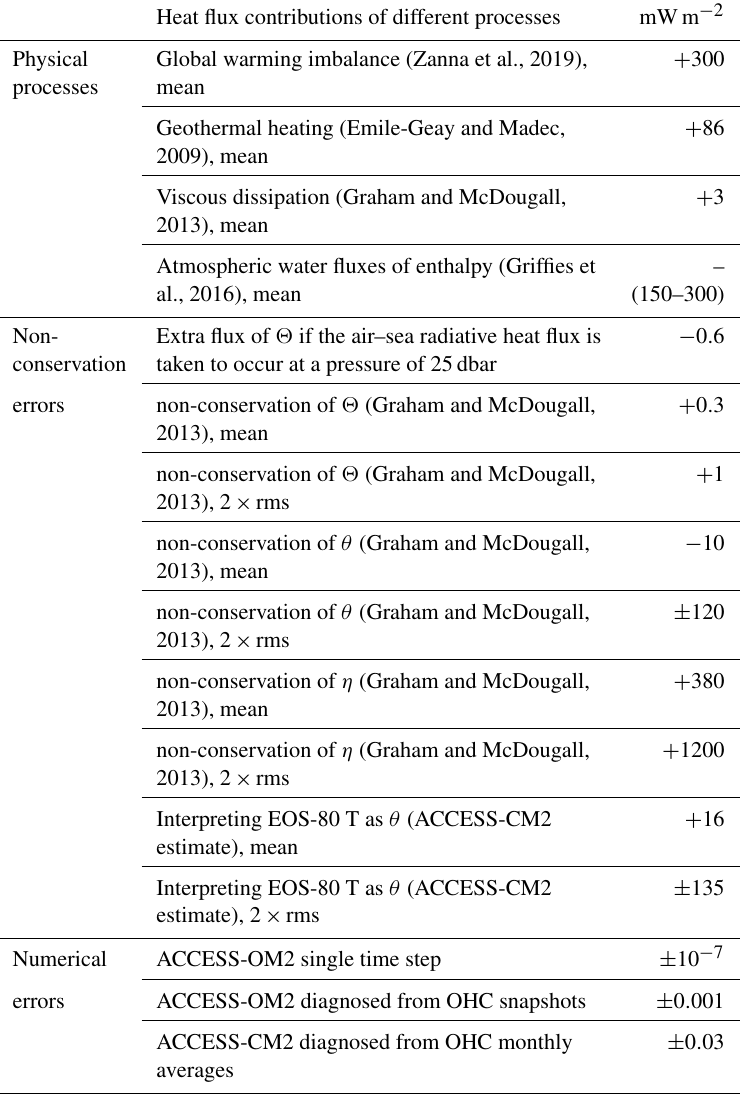
Table 1. Summary of the impact of various processes and modelling errors on the global ocean heat budget and its imbalance (units: mWm − 2 ). Numerical errors are diagnosed from either ACCESS-OM2 (machine precision errors) or ACCESS-CM2 (associated with not having access to OHC snapshots; OHC – ocean heat content). Numbers from interior processes are converted to equivalent surface fluxes by depth integration. The sign convention here is that a positive heat flux is heat entering the ocean or warming the ocean by internal dissipation. The symbol η in this table stands for